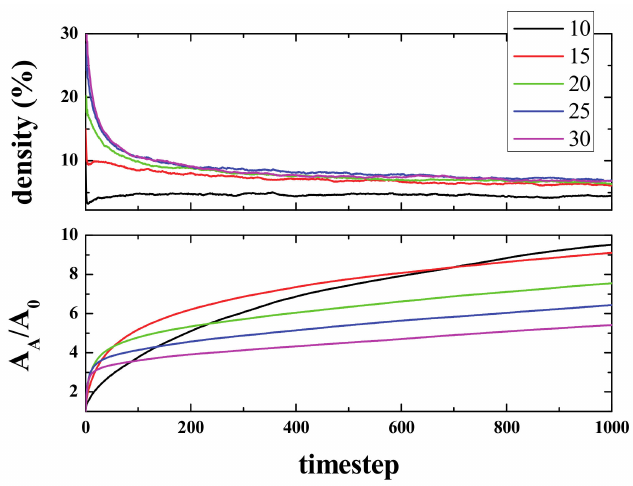
Figure 2. (Color online) Density (top panel) and Activated Area (bottom panel) versus time for five different initial densities, ranging from 10% (black), 15% (red), 20% (green), 25% (blue), and 30%